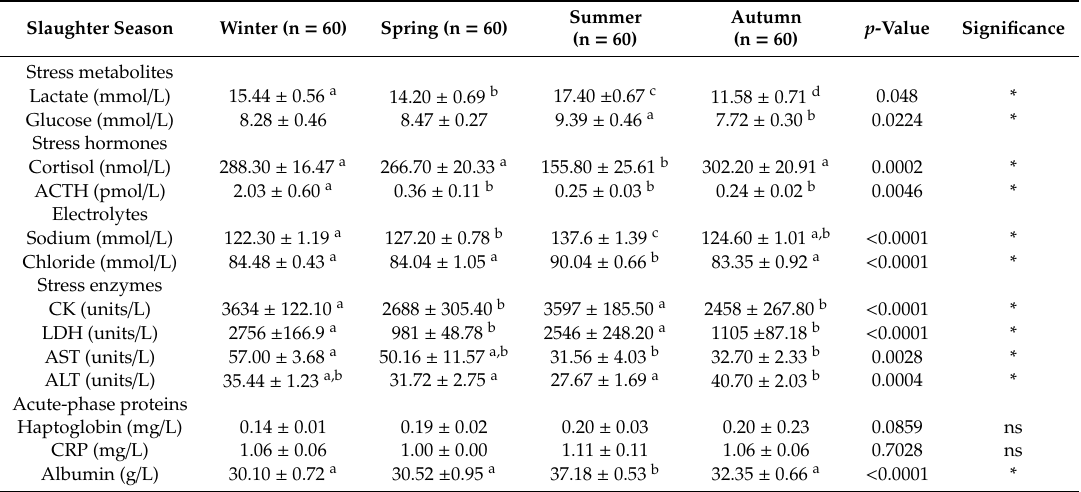
Table 9. Relationships between slaughter season and physiological stress biomarkers in slaughter pigs (mean value ± standard